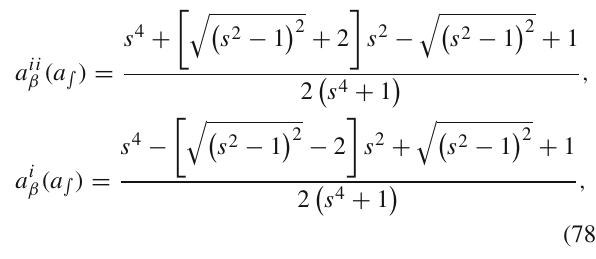
Fig. 22 Study of origins a ± in terms of the outer and inner horizon 0 frequency. See Sect. 3.2 and Eqs. (89) and (93). Upper panels left: plots as functions of the tangent spins a 0 on the outer of the bundle origin a ± 0 and inner horizon, respectively, for different planes σ . The logarithm